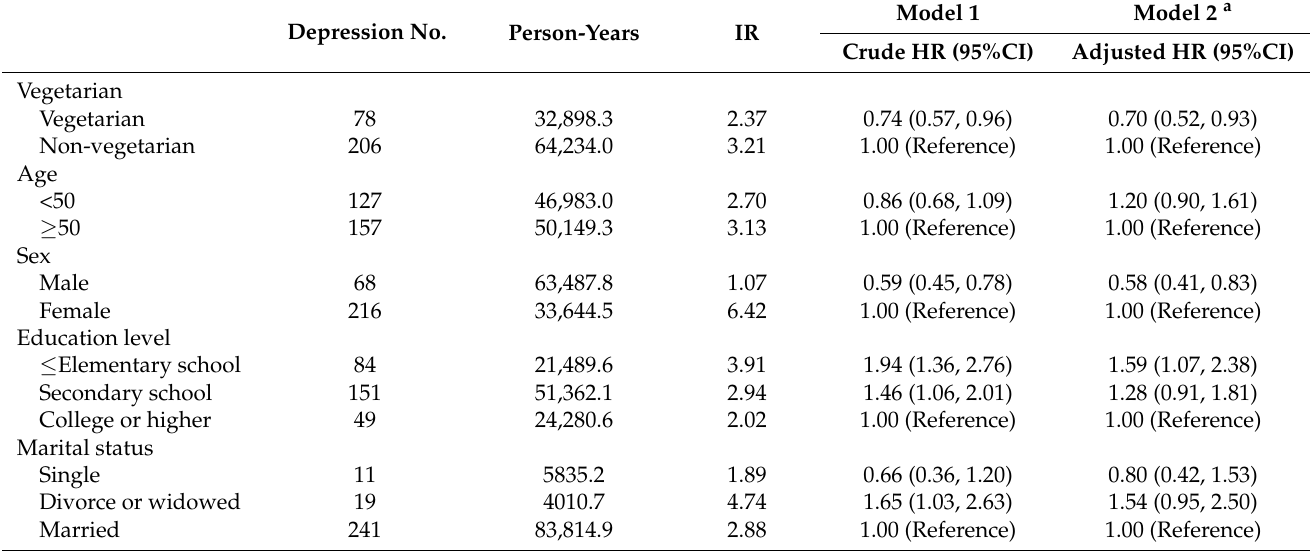
Table 2. Cox proportional hazard model for the risk of developing depressive